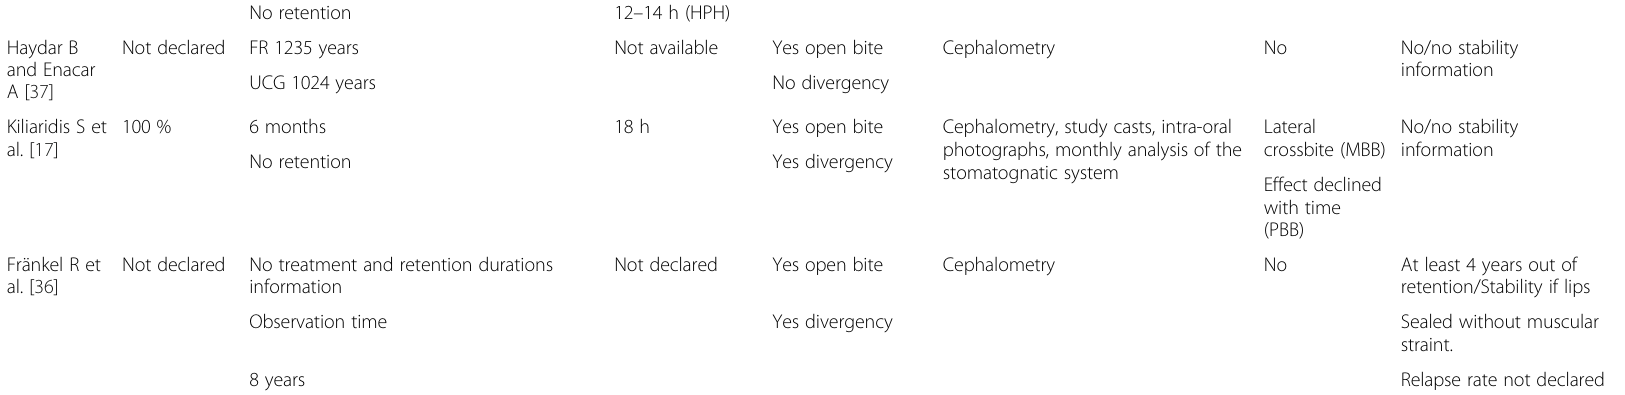
Table 2 Results: success rate, treatment duration, reduction of open bite and divergency, side effects and stability